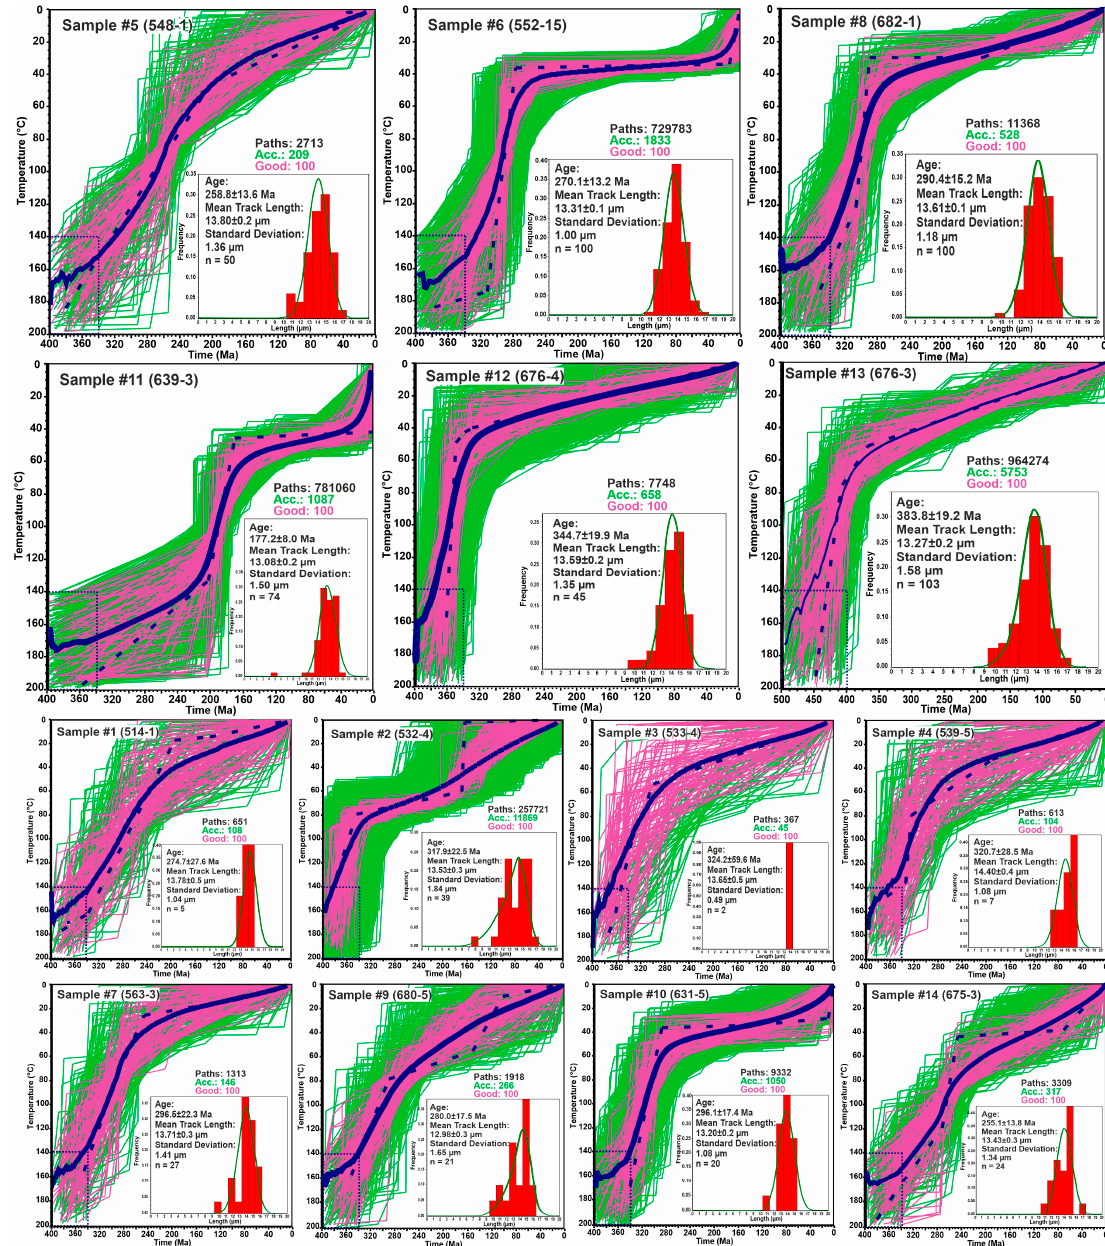
Figure 3. Results of the thermal modeling showing time-temperature (t-T) histories that explain the measured apatite fission-track (AFT) age and track length data. Results are shown as path envelopes encompassing the thermal histories that generated good fits (purple curves) and acceptable fits (green curves) to the data. The best fit path is shown in dotted blue line and the weighted mean path in continuous blue line. Insets: the measured track length distribution histograms (red) and predicted length distributions (green lines). Dashed boxes are constraint boxes. Note that t-T histories for sample #13 (676-3) begin at 500 Ma. Small plots indicate less reliable thermal histories due to the low number of available confined track lengths in those